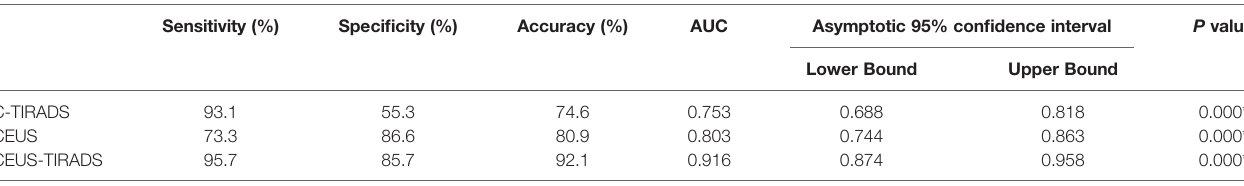
*P Value <0.05 indicates statistical signi fi cance.